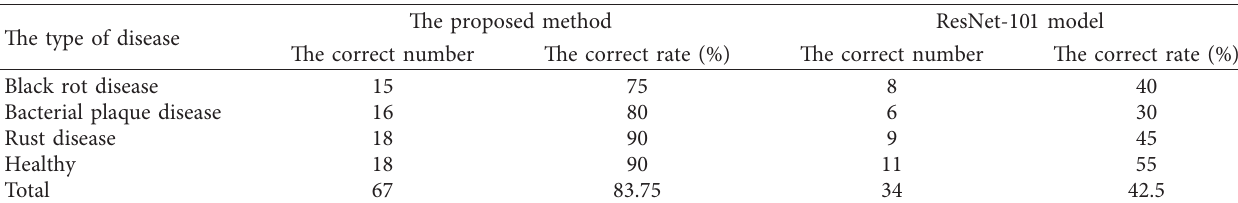
Table 5: The comparison between the proposed method and ResNet-101